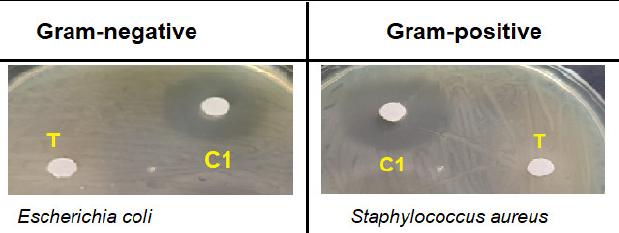
Figure 4. Negative zone of inhibition of Saussurea costus aqueous extract (100 mg/mL) (T) compared to chloramphenicol (2.5 mg/mL) (C1) against tested bacteria.